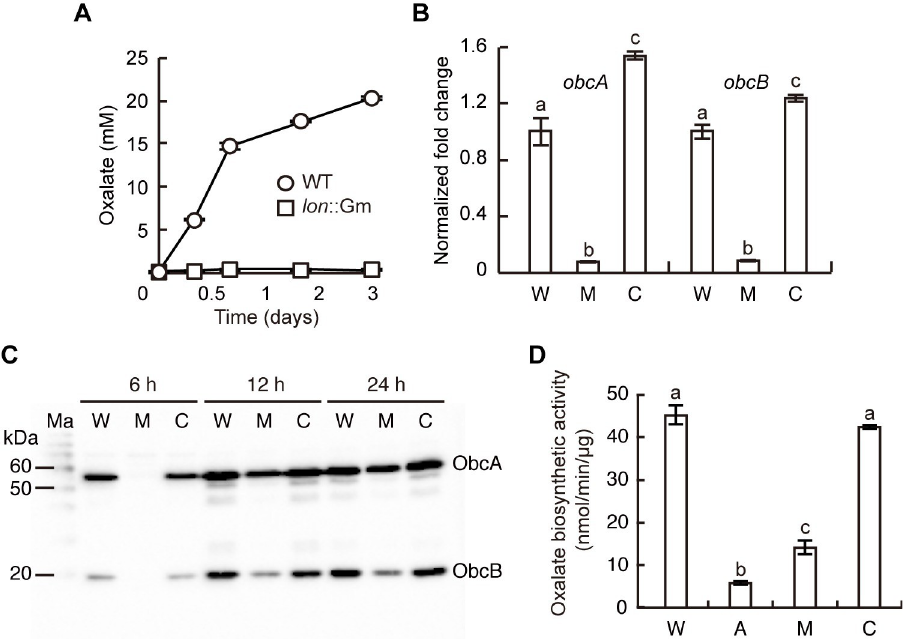
Fig 4. Reduced production of oxalate by the lon mutant of B . glumae . (A) Oxalate in the culture supernatant of each strain was measured at a designated time point. The wild type biosynthesized approximately 20 mM oxalate, whereas the lon mutant produced very little oxalate throughout its growth. (B) Expression of obcA and obcB in each strain during mid-log phase was determined by qRT-PCR. W, M, and C denote the wild type, lon mutant, and complemented strains, respectively. The letters (a, b, and c) above each mean indicate significant differences based on a one-way ANOVA, followed by Tukey’s post-hoc analysis. A value of p < 0.05 indicates significant differences among the strains. (C) Western blot analysis using ObcA and ObcB antibodies at 6, 12, and 24 h after subculture indicated lower levels of ObcA and ObcB in the lon mutant than in the wild type. Ma, W, M, and C denote the molecular markers, the wild type, lon mutant, and complemented strains, respectively. (D) The specific oxalate biosynthetic activity of each strain during early stationary phase was determined. W, A, M, and C denote the wild type, obcA mutant, lon mutant, and complemented strains, respectively. The letters (a, b, and c) above each mean represent significant differences based on a one-way ANOVA, followed by Tukey’s post-hoc analysis. A value of p < 0.05 represented significant differences among